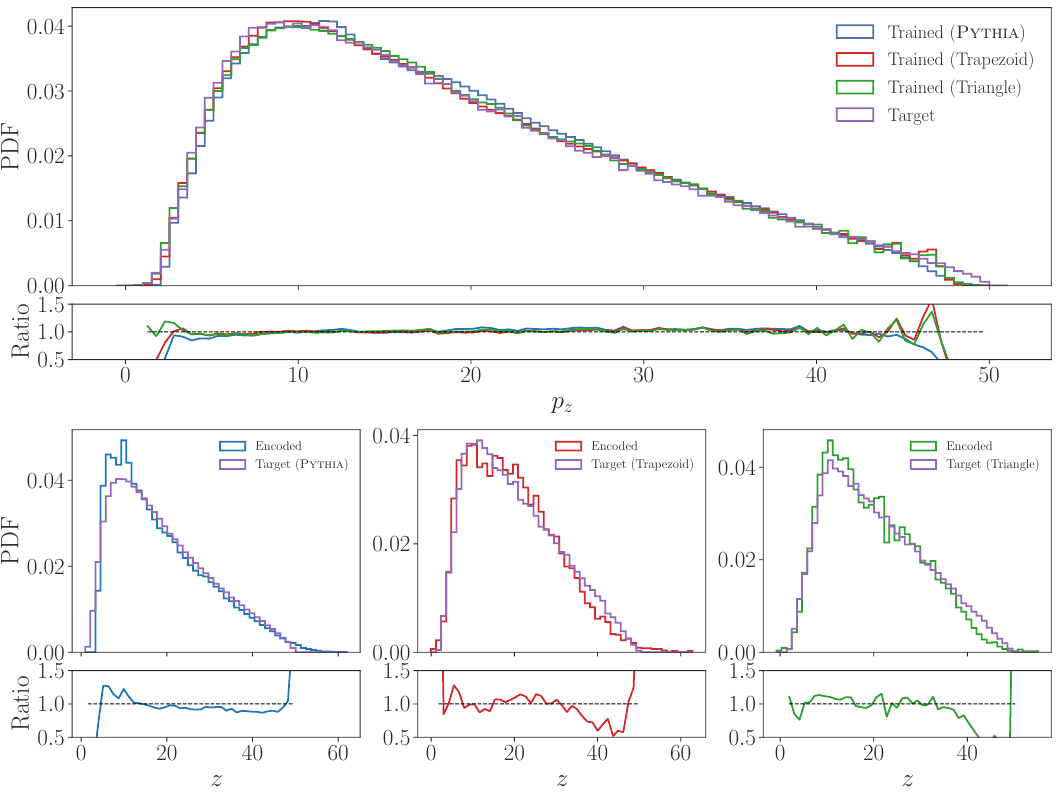
Figure 8: Top: ML HAD generated p distributions for first-hadron emission from a z string with an energy E = 50 GeV, using three different latent-space distributions, P YTHIA (blue), trapezoidal (red), and triangular (green), compared to the P YTHIA generated target distribution (purple), as well as the ratios of ML HAD generated to P YTHIA generated distributions. Bottom: comparison of the trained and target latent- space distributions for the three